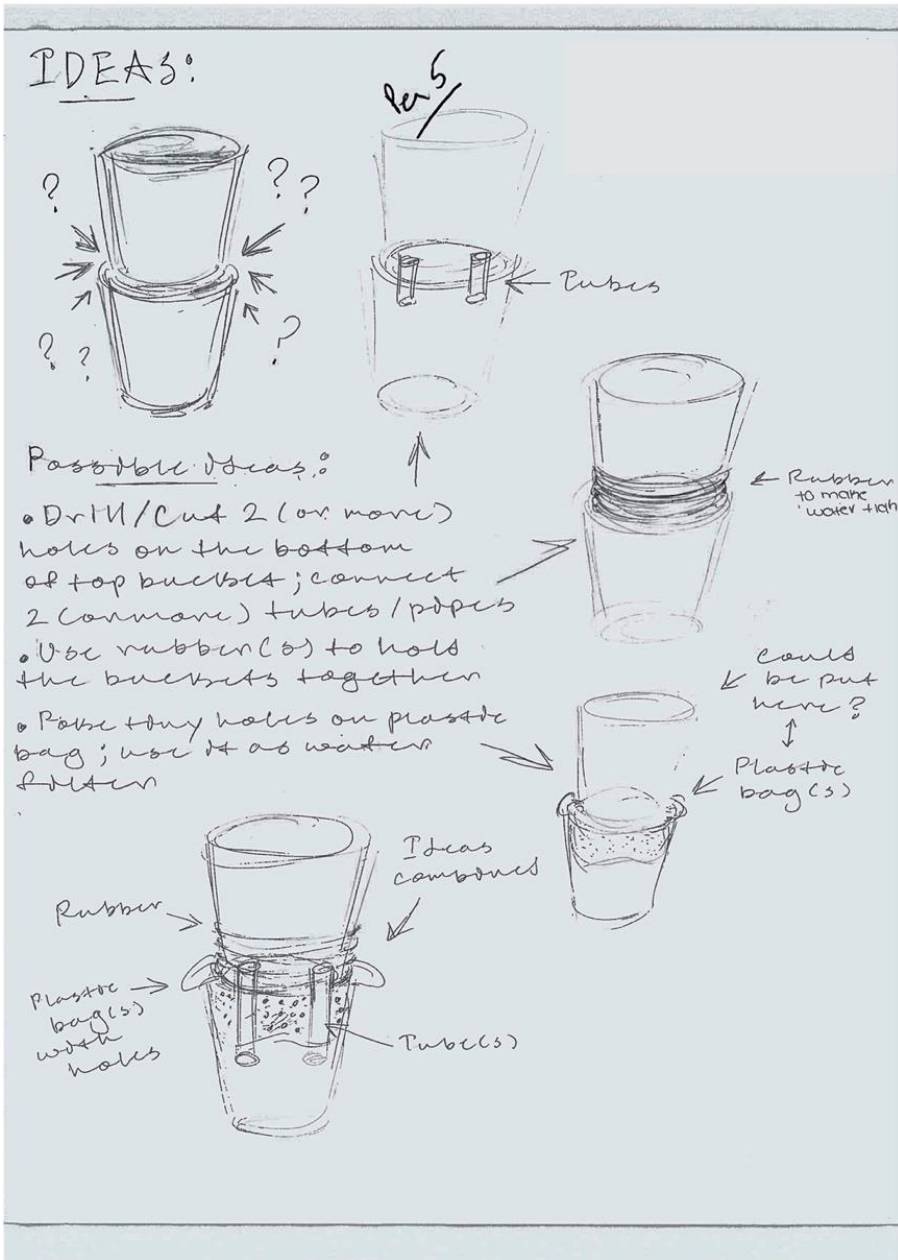
Figure 2. Sample student design for two-bucket BSFs.